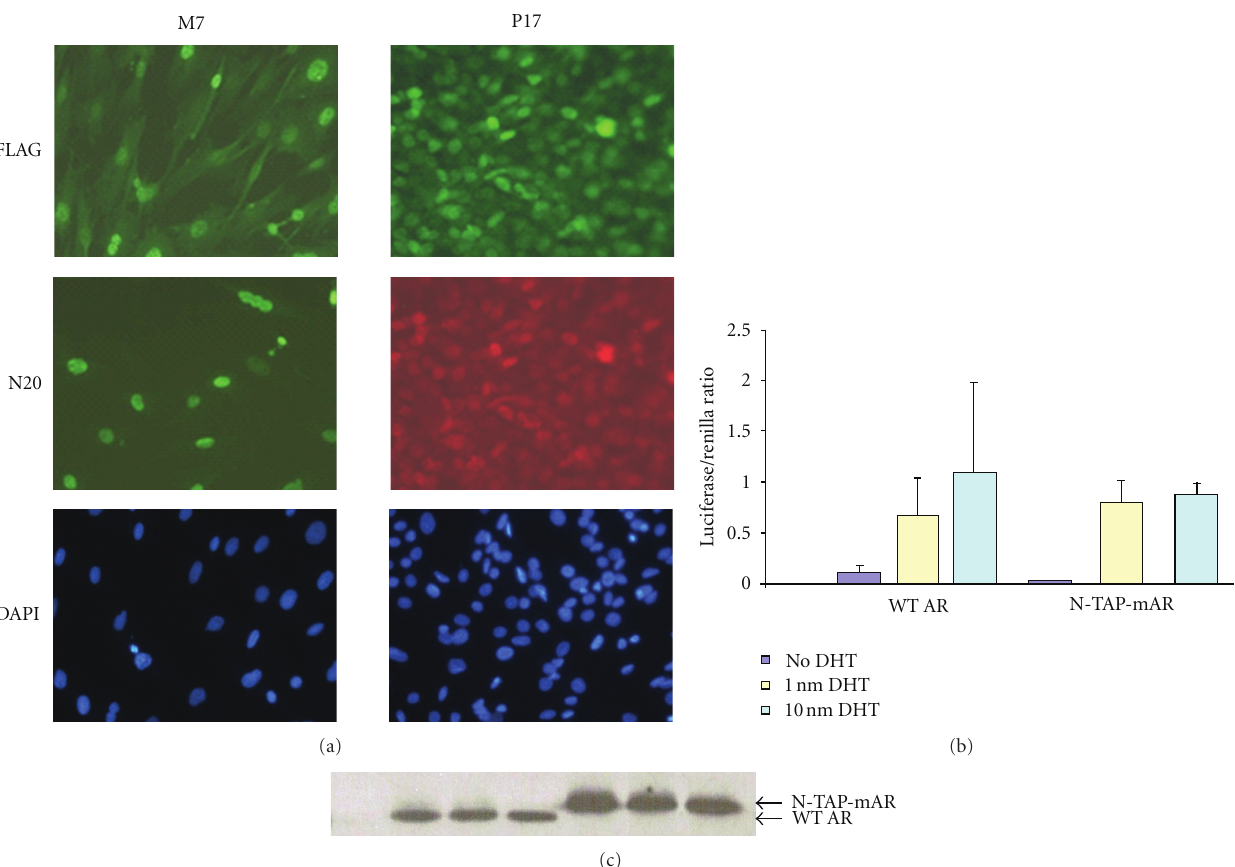
Figure 2: Nuclear localization and transactivation ability of N-TAP-mAR. (a) Immunostaining of a stable mesenchymal cell line M7 and a stable epithelial cell line P17 expressing N-TAP-mAR. The FLAG antibody detects tagged androgen receptor only. N20 antibody recognises both endogenous AR and N-TAP-mAR. Nuclei staining with DAPI indicates the percentage of cells expressing NTAP-mAR. (b) The ability of the modified N-TAP-mAR and WT-AR to activate a glucocorticoid response element (GRE) was assayed in COS-1 cells in a transient transfection luciferase assay. GRE promoter activation, shown here on the y -axis as luciferase/renilla ratio, was similar for the tagged and nontagged androgen receptor. (c) Tagged androgen receptor expression (N-TAP-mAR) was elevated in the Western blot done with protein extracts from the transactivation samples relative to